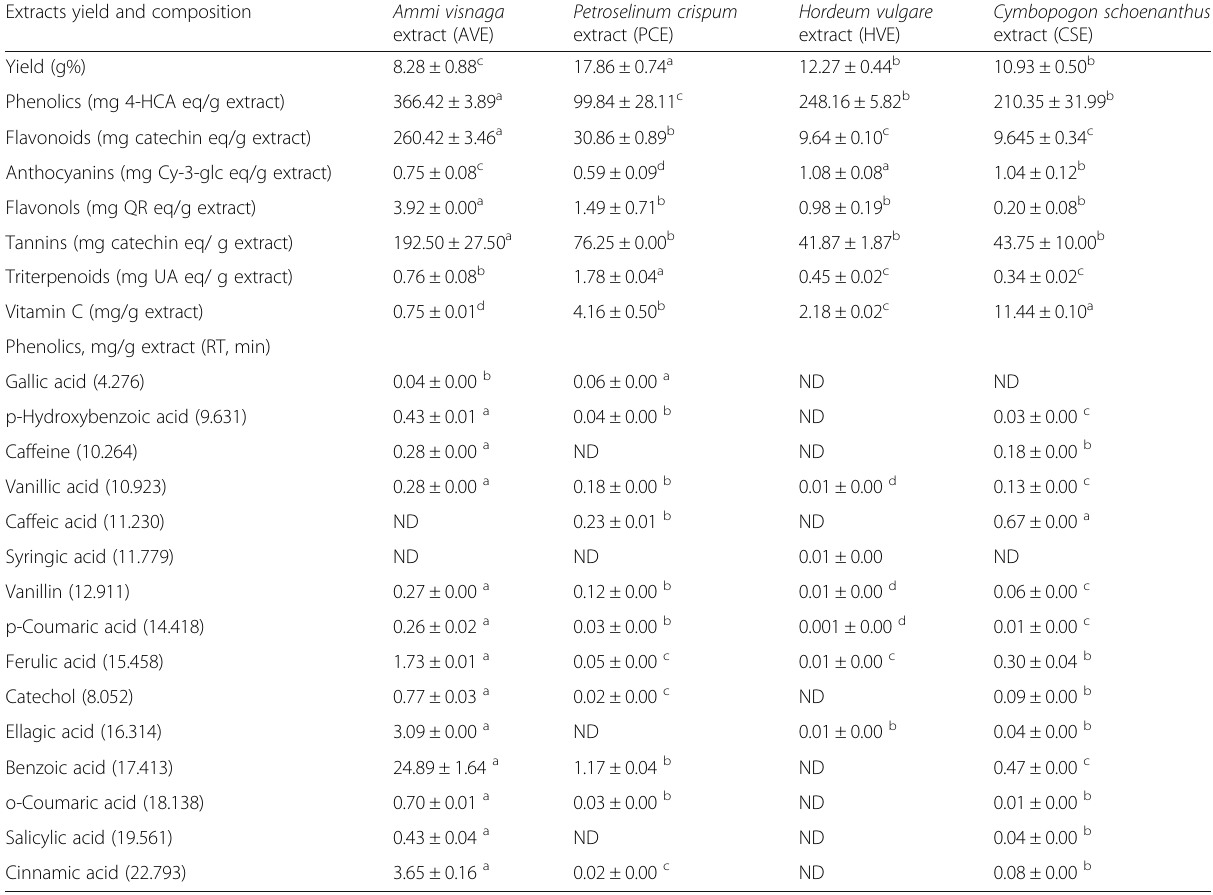
Table 1 The yield and chemical composition of the studied plant extracts Extracts yield and